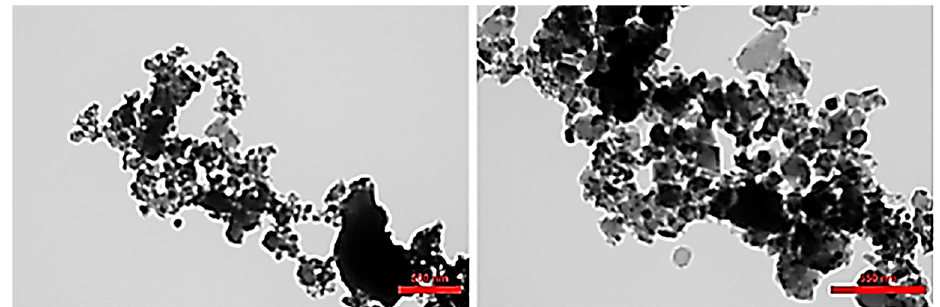
Figure 10. TEM analysis of SSE@GO-CuFe 2 O 4 nanocomposite.